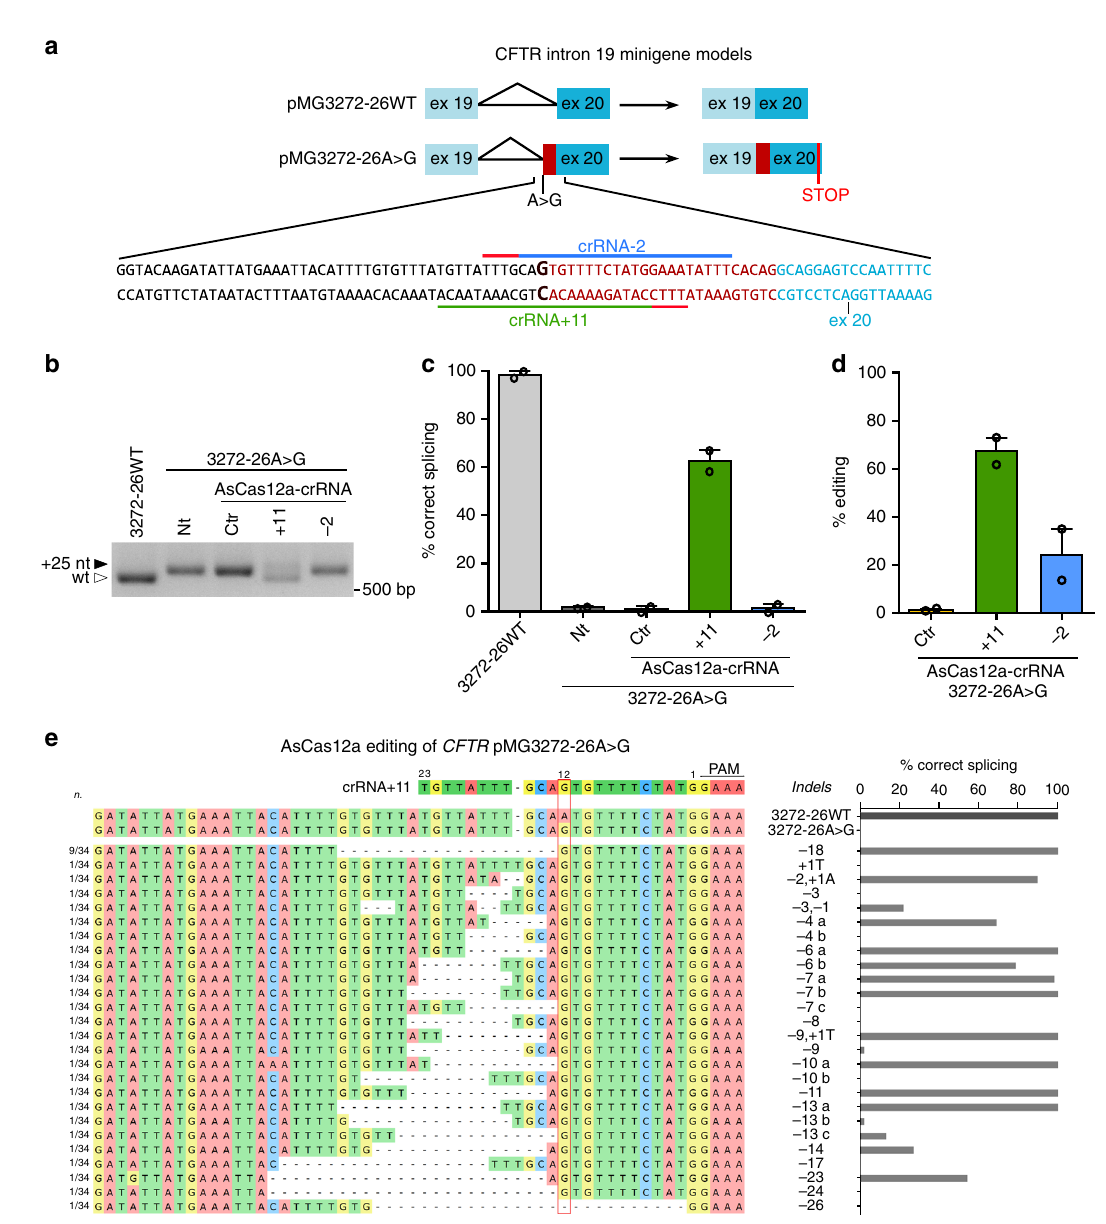
Fig. 1 Splicing correction in CFTR 3272-26A>G minigene model by AsCas12a editing. a Scheme of the CFTR minigenes containing a sequence (~1.3 kb) corresponding to the CFTR region extending from exon 19 to 20 either wild type (pMG3272-26WT) or 3272-26A>G mutated (pMG3272-26A>G). Exons are shown as boxes, introns as lines; the expected spliced transcripts are represented on the right according to the presence or absence of the 3272- 26A>G mutation. The lower panel shows nucleotide sequence and intron – exon boundaries nearby the 3272-26A>G mutation (labeled in bold) and the target AsCas12a-crRNAs position (underlined, with the PAM in red). b Splicing pattern analyzed by RT-PCR in HEK293/pMG3272 – 26A>G cells following treatments with AsCas12a-crRNA control (Ctr) or speci fi c for the 3272-26A>G mutation ( + 11 and − 2). Black-solid arrow indicates aberrant splicing, white-empty arrow indicates correct splicing. Representative data of n = 2 independent experiments. c Percentages of correct splicing measured by densitometry and d editing ef fi ciency analyzed by TIDE in cells treated as in b . Data are means ± SEM from n = 2 independent experiments. e Indels triggered by AsCas12a-crRNA + 11. The 3272-26A>G locus from cells edited by crRNA + 11 were ampli fi ed, cloned in the minigene backbone and Sanger sequenced (34 different clones, left panel), or analyzed as in b for produced splicing pattern (right panel and Supplementary Fig. 3b). pMG3272-26WT